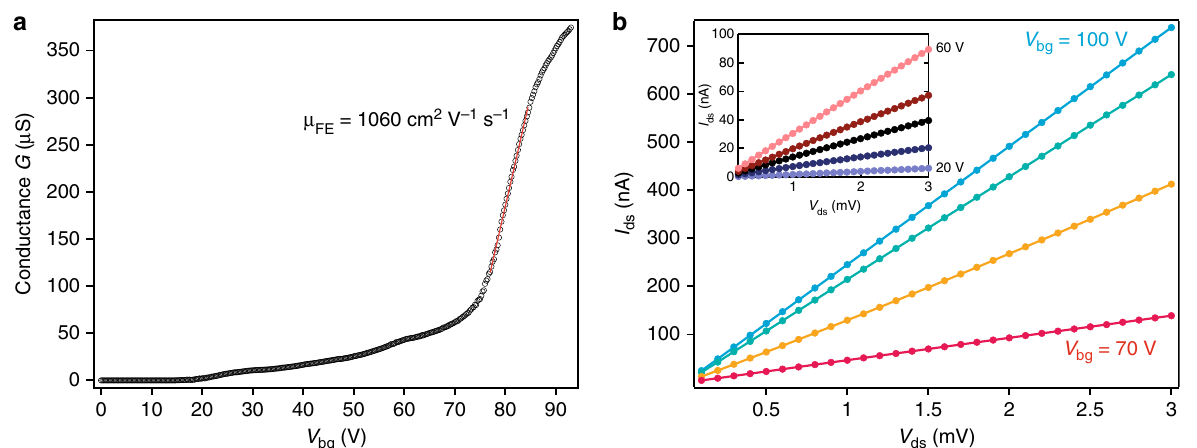
Fig. 2 Electric performance of the encapsulated monolayer MoS 2 with FLG contacts at 1.4 K. a Conductance of the device as a function of the back-gate voltage. A sharp turn-on at ~75 V marks the conduction band edge and yields a mobility above 1000 cm 2 V − 1 s − 1 . b Output characteristics of the device at different V bg from 70 to 100 V in steps of 10 V. In all cases, we observe a linear contact characteristic. Inset: current-voltage characteristics in the lower range of V bg from 20 to 60 V in steps of 10 V